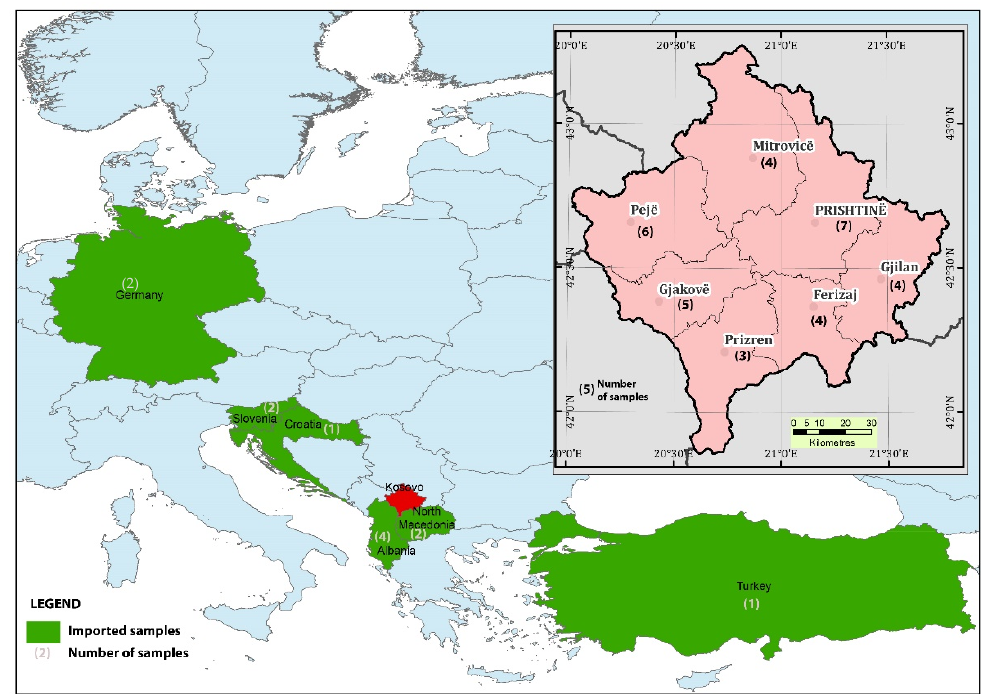
Figure 1. Geographical origin of the studied honey samples.